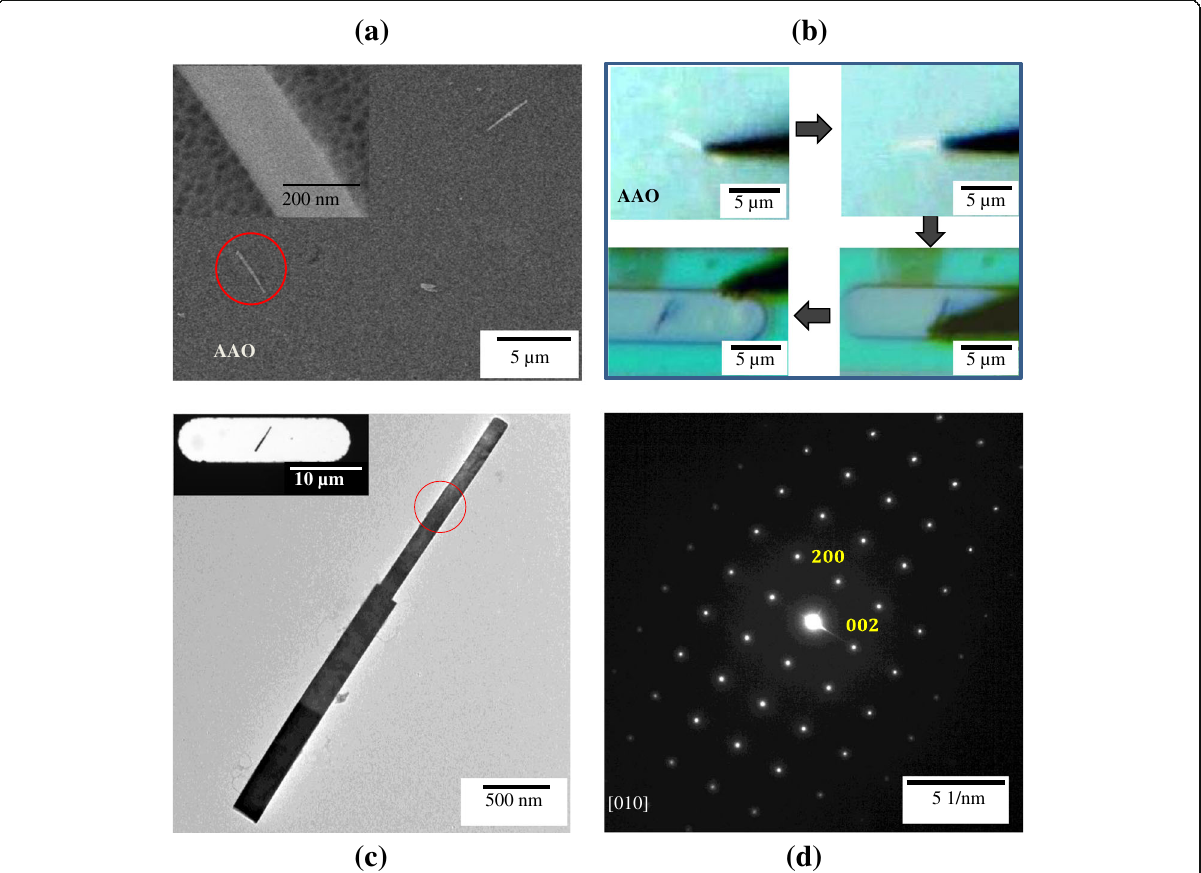
Fig. 4 Transferring process of KNbO 3 nanowire on MEMS window from AAO filter a SEM image of KNbO 3 nanowires dispersed on AAO. The inset shows 20 nm pore arrays of AAO. b KNbO 3 nanowire transferring process observed by optical microscopy in real time using tip of radius < 100 nm. c TEM image of transferred KNbO 3 single nanowire on MEMS window. The inset shows low magnification TEM image of sample. d SAED pattern of red circled part in